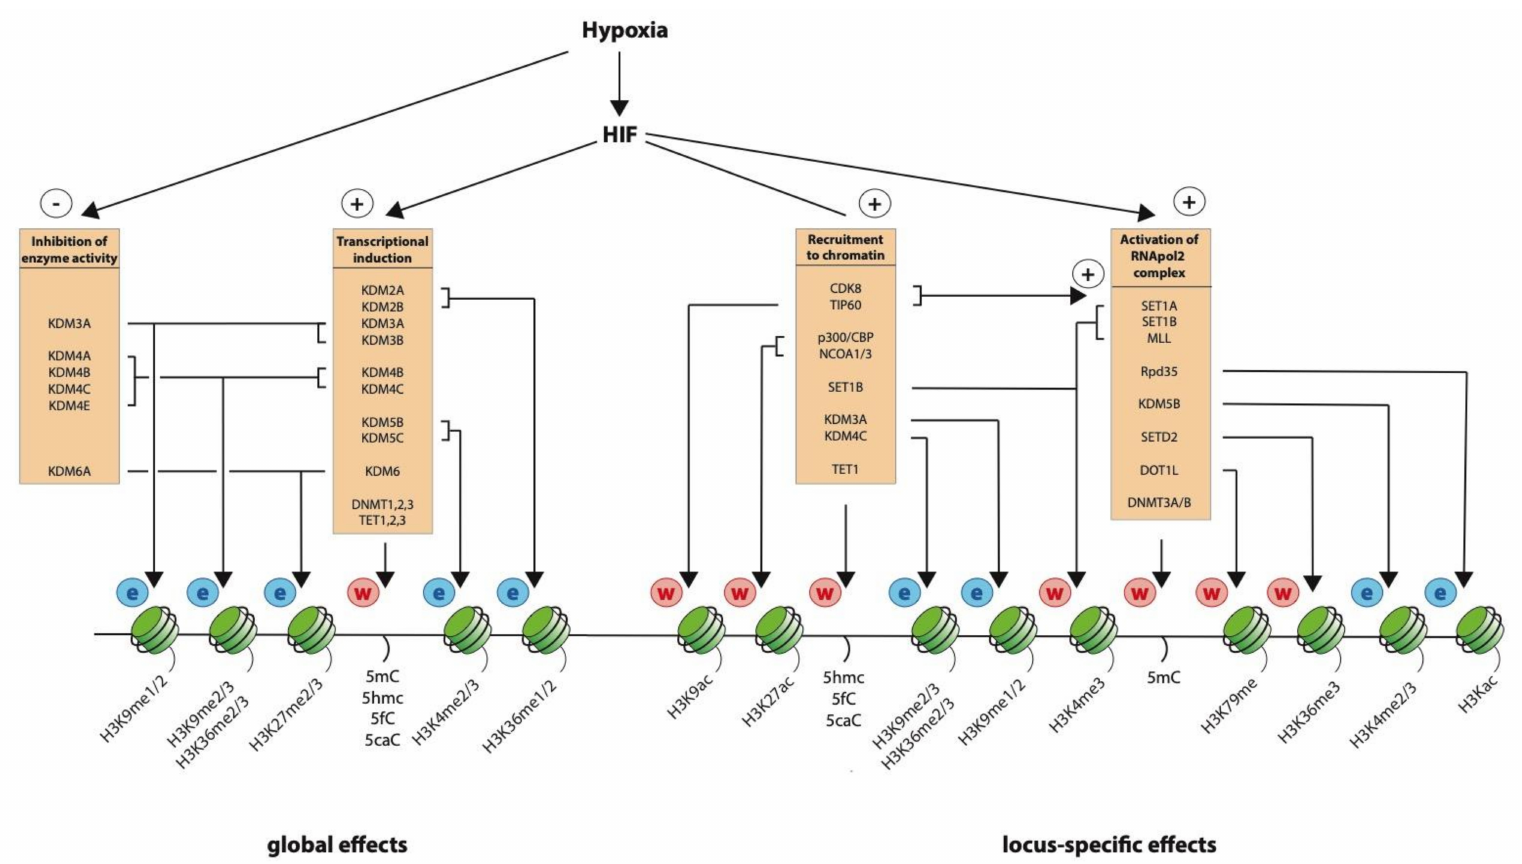
Figure 4. Regulation of chromatin structure by hypoxia on a global and locus-specific level. Independent of the HIF transcriptional pathway, hypoxia globally inhibits the activity of many 2-OG dependent dioxygenases that control histone and DNA modifications. The HIF transcription factor complex, activated by hypoxia, also works to control histone and DNA modifications on a global level by transcriptional induction of these same readers and writers. To cause locus-specific e ff ects, HIF recruits these enzymes to chromatin and activates the RNApol2